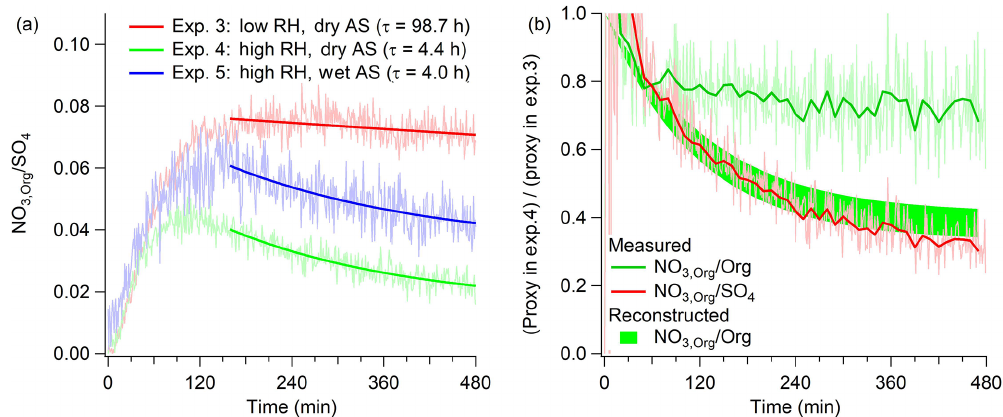
(cid:113) ) and the exponential fits with corresponding characteristic